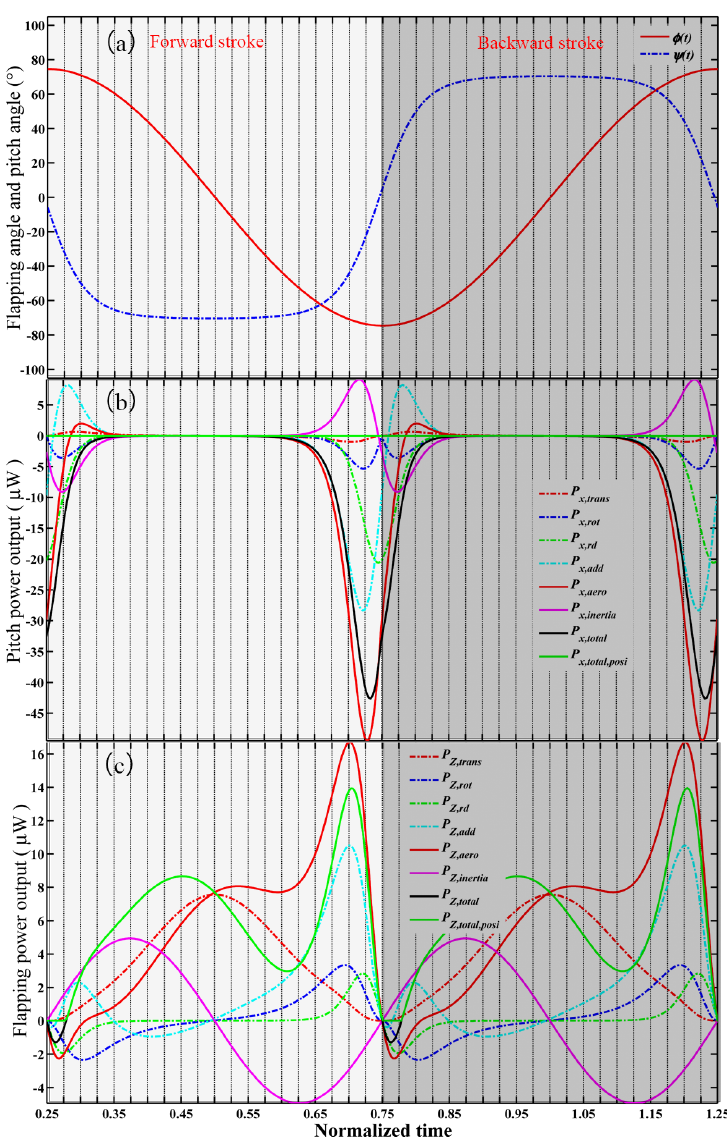
Figure 11. Wingbeat motion ( a ), pitch and flapping power output of single wing ( b , c ) for combined optimal WGP and WKP.